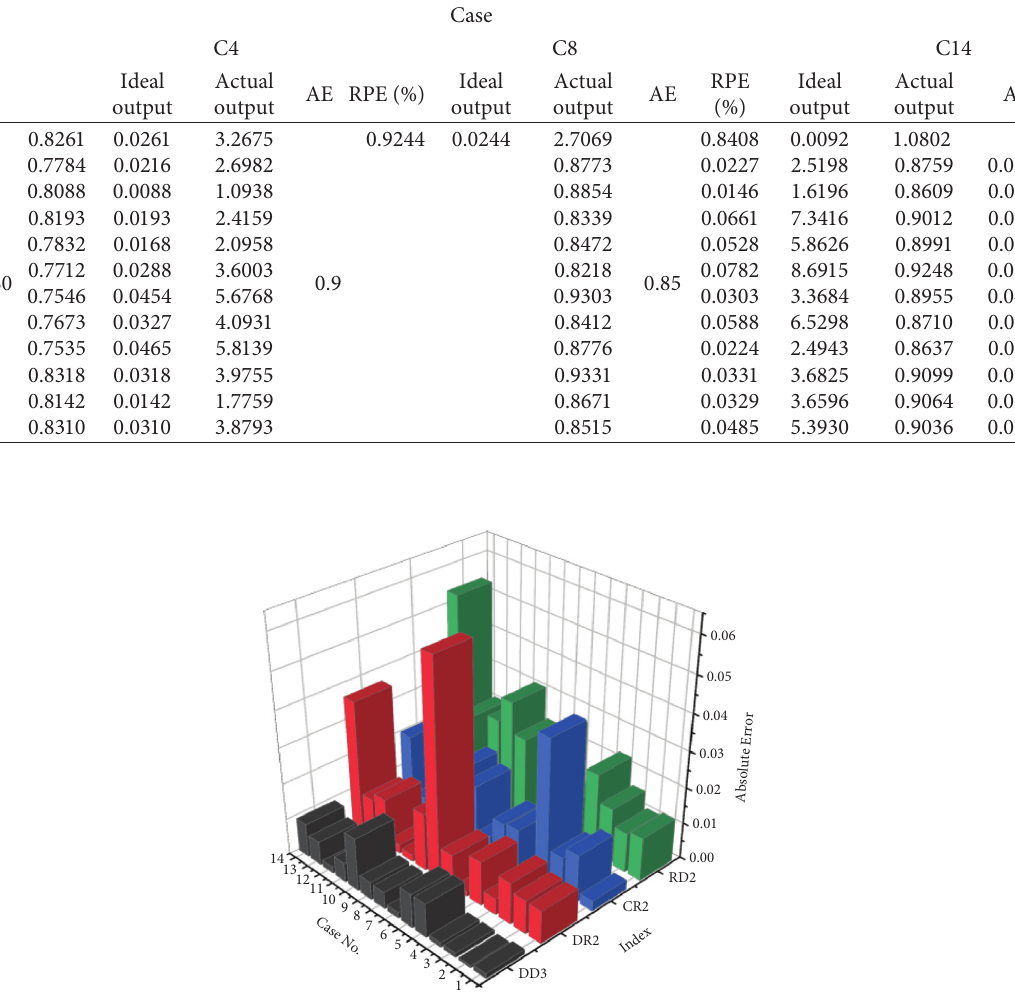
3 , DR 2 , CR 2 , and RD 2 .